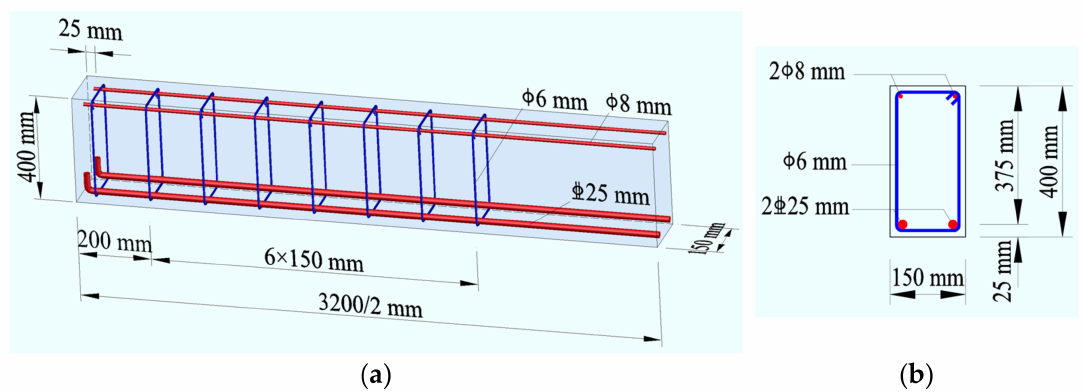
Figure 1. Layout of reinforcements in test beams: ( a ) longitudinal section; ( b ) transversal section. The shear span to depth ratio of the test beams λ = 2.5, the shear span of test beam a = 905 mm. The spacing of stirrups s = 150 mm, the stirrups ratio ρ sv = 0.25%. The measured sectional dimension, the shear force V u(1) computed by Formula (1), and that V u(4) (= M fu /a) computed by Formula (4) for the test beams are also presented in Table 1.